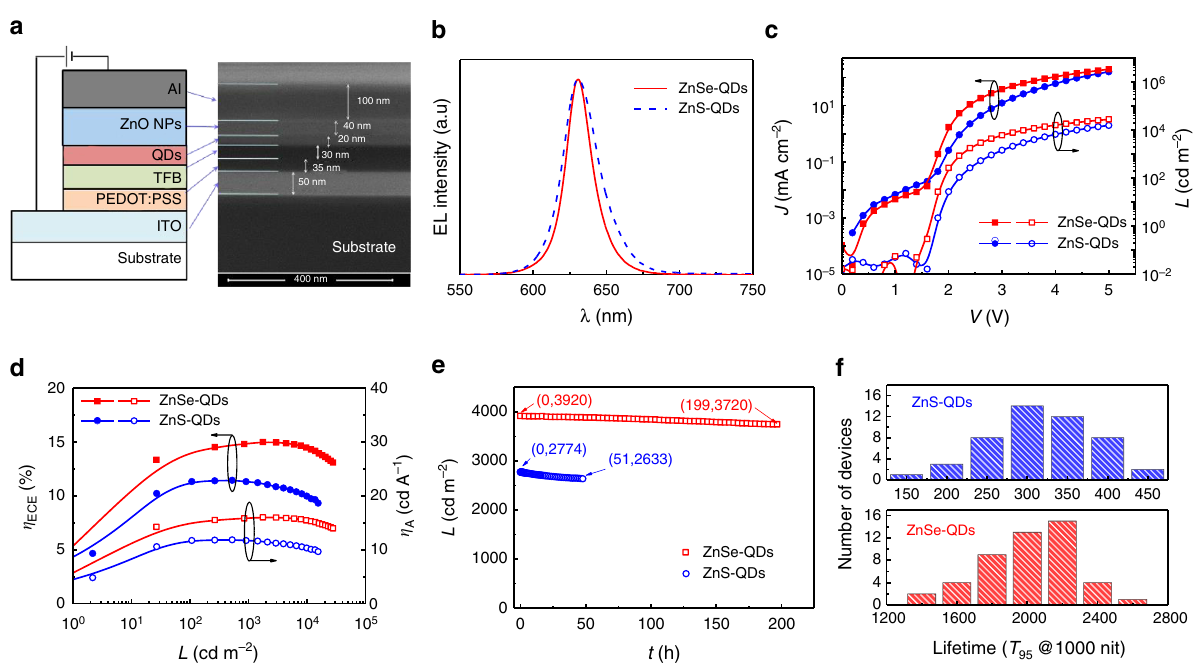
Fig. 2 Device performance. a Device structure and cross-section scanning electron microscopy (SEM) image with layer thicknesses labeled. b Electroluminescence spectra of the ZnSe-QD and ZnS-QD devices. c Current density-luminance-voltage ( J - L - V ) characteristics for the two devices. d Current ef fi ciency ( η A ) and external quantum ef fi ciency ( η EQE ) as a function of luminance for the two devices. e Stability data (luminance vs. time) for the two devices. f Histograms of T 95 lifetime with initial luminance of 1000 cd m − 2 measured from 48 ZnSe-QD devices and 48 ZnS-QD